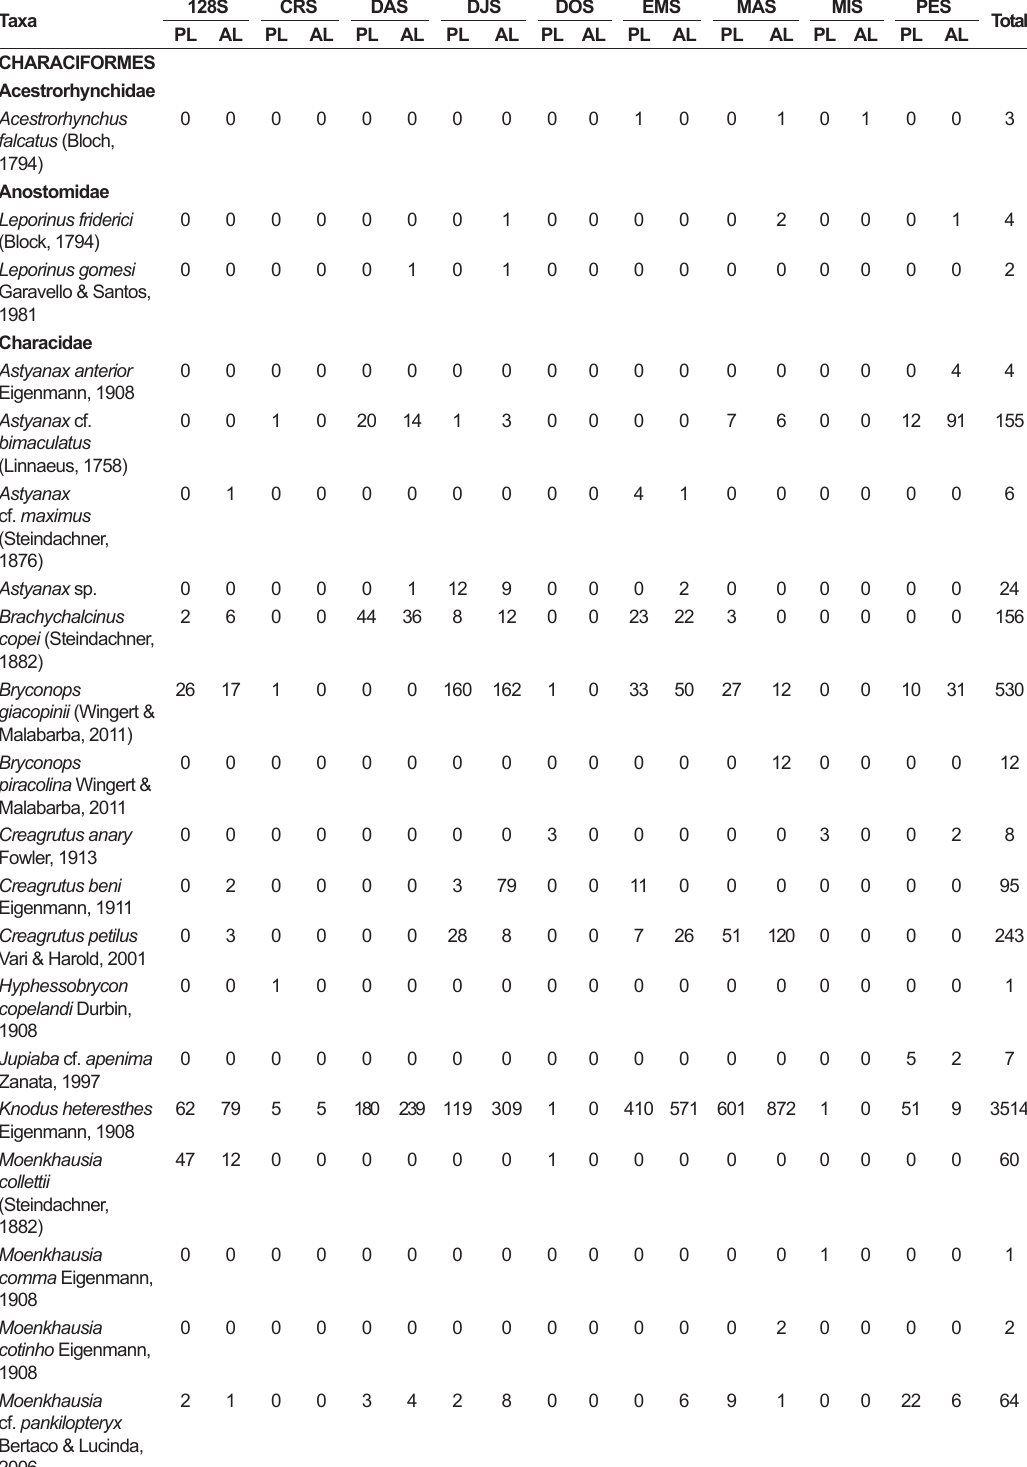
Table 3. Abundance data for species collected in presence of luminosity (PL) and absence of luminosity (AL) in each stream in the Machado River basin, July 2013 to May